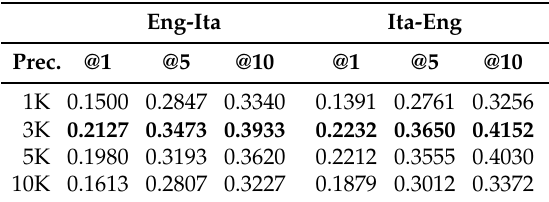
Table 7. Experiments with different training set